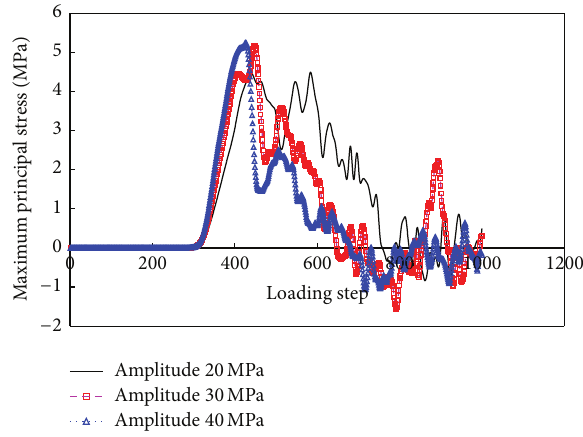
Figure 5: Variation law of maximum principle stress on numerical sample